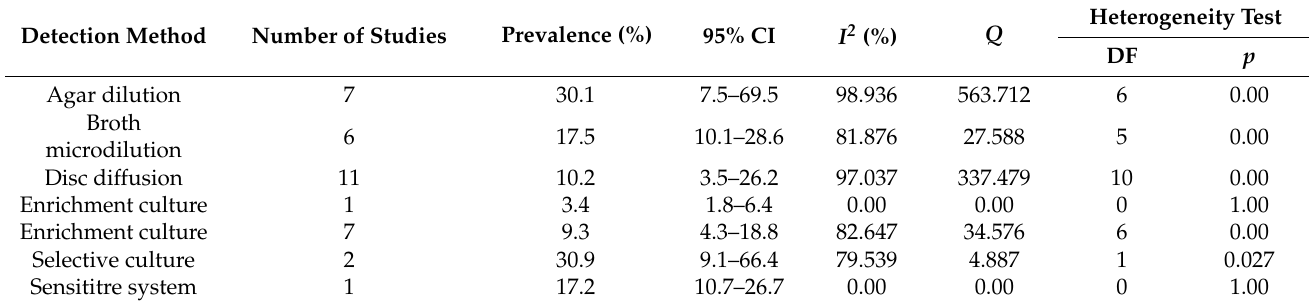
Table 6. Subgroup analysis for comparison of prevalence of VRE in companion animals according to detection